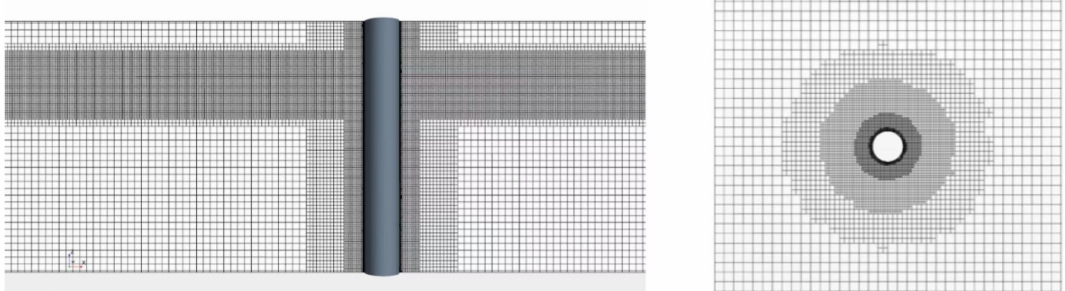
Figure 4. Diagram of grid